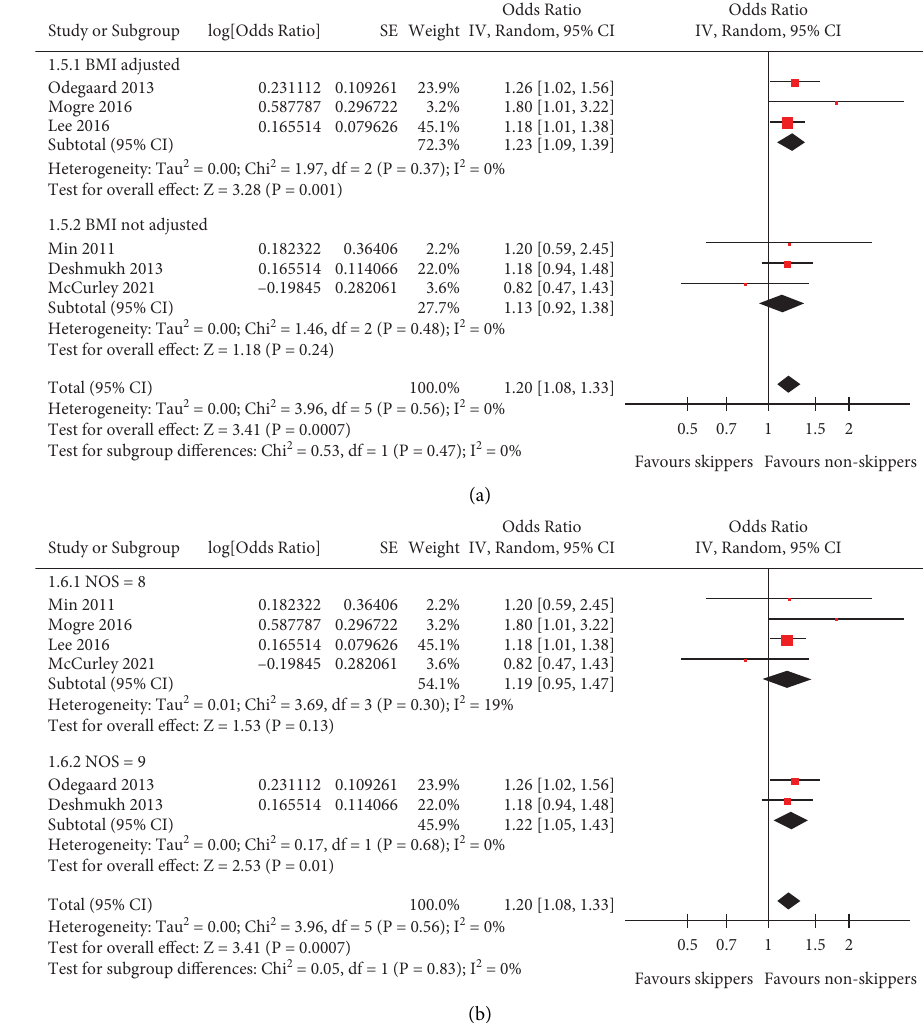
Figure 4: Forest plots for the subgroup analyses of the association between skipping breakfast and hypertension in the adult population. (a) Subgroup analysis according to the adjustment of BMI. (b) Subgroup analysis according to the quality scores.